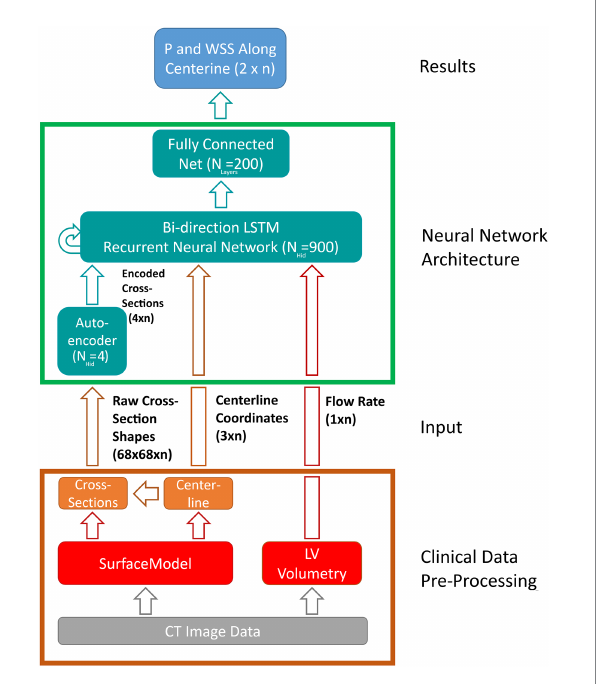
workflow for computing pressure and wall-shear-stress (WSS) along the vessel centerline. Clinical data pre-processing includes the extraction of the vessel surface model as well as peak systolic flow rate from multiphasic computed tomography (CT) image data. Vessel centerline and cross-section shapes are then derived from the surface model and passed to the ANN directly (centerline- coordinates) and through an auto encoder, respectively. A long- short-term-memory (LSTM) recurrent neural network computes the flow states at each centerline point based on centerline coordinates, encoded cross-sections and flow rate. Lastly, a fully connected layer derives pressure and wall-shear-stress along vessel centerline from the flow states provided by the LSTM. Hidden state and input/output sizes are also provided in the